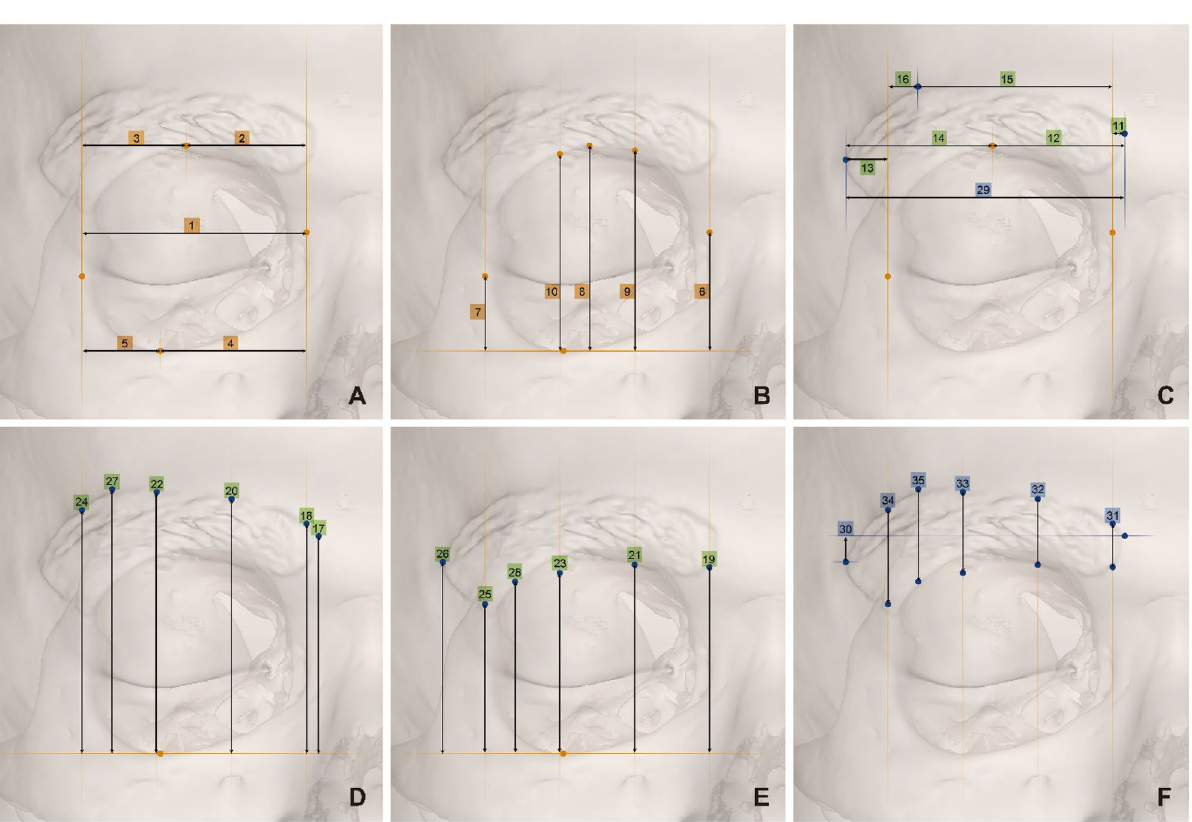
Figure 3. Thirty-five measurements between landmarks and reference planes (the numbers also indicate each measurement code; see Supplementary Table S1). Perpendicular distances between landmarks and reference planes. ( A ) Width measurements of the orbit; ( B ) height measurements of the orbit; ( C ) width measurements of the eyebrow; ( D ) height measurements of the upper border of the eyebrow; ( E ) height measurements of the lower border of the eyebrow; ( F ) height measurements of the eyebrows (orange colored dots are bony landmarks; blue colored dots are skin